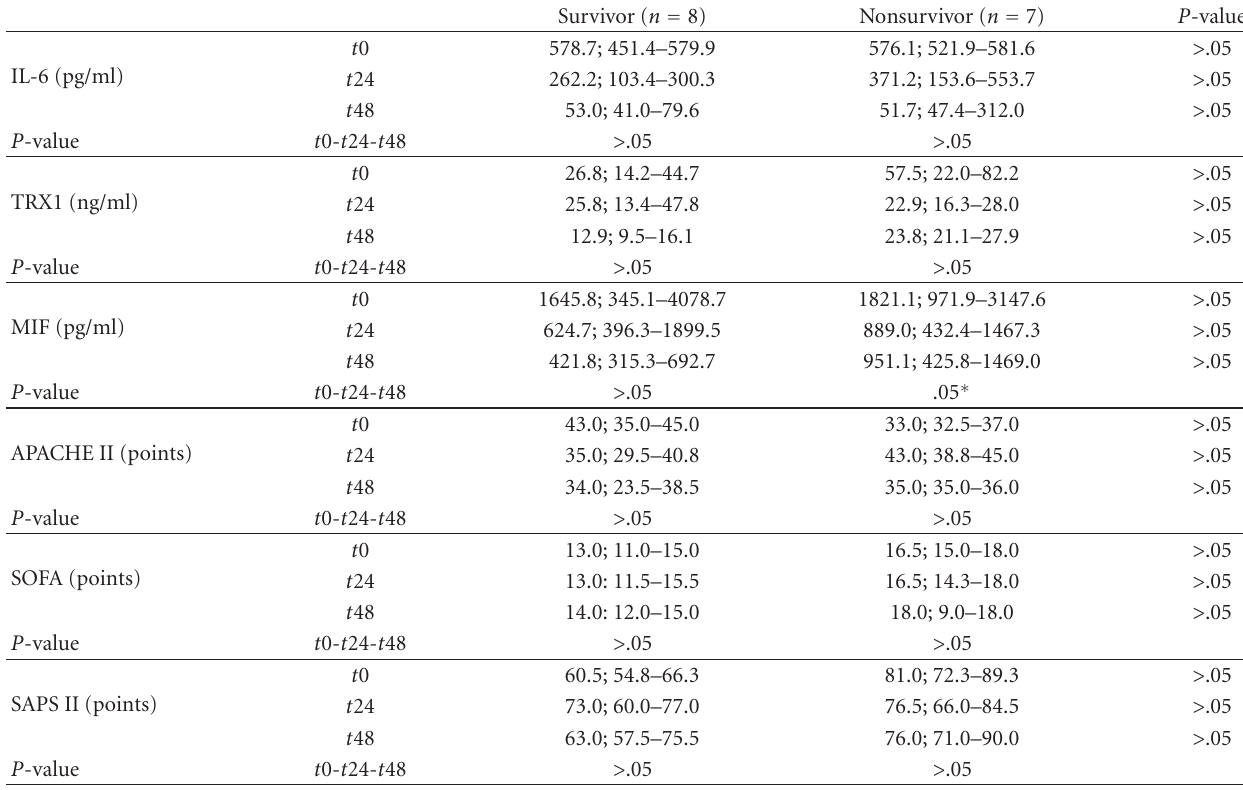
Table 2: Comparison of IL-6, TRX1, and MIF plasma levels, as well as APACHE II, SAPS II, and SOFA scores in survivors and nonsurvivors in the septic group at baseline and at 24 and 48